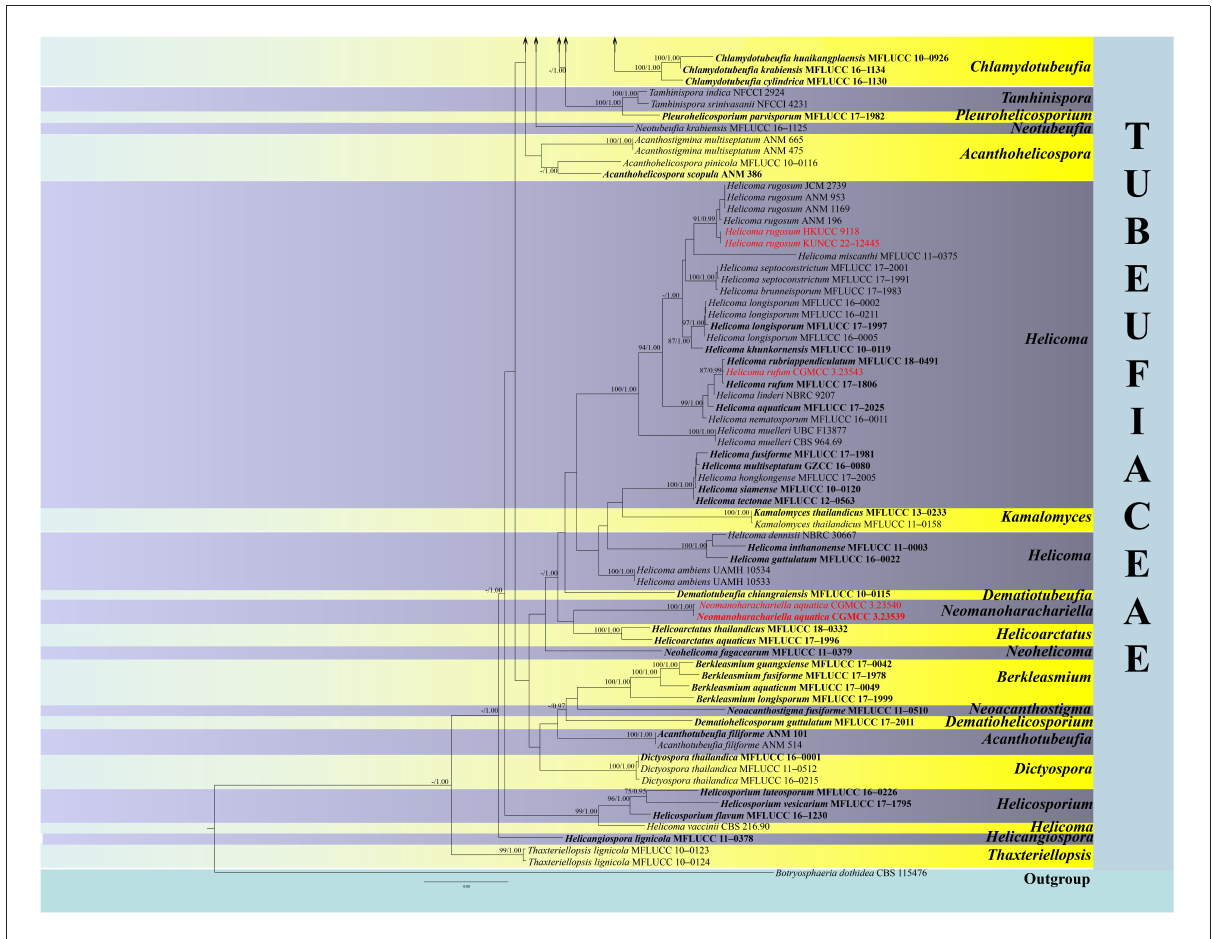
FIGURE1 Phylogram generated from maximum likelihood analysis (RAxML) of Tubeufiaceae based on ITS, LSU, tef 1- α , and RPB2 sequence data. Maximum likelihood bootstrap values equal to or above 75% and Bayesian posterior probabilities (PP) equal to or above 0.95 are given above the nodes. The tree is rooted at Botryosphaeria dothidea CBS 115476. Newly-generated sequences are indicated in red. Ex-type strains are indicated in black/red